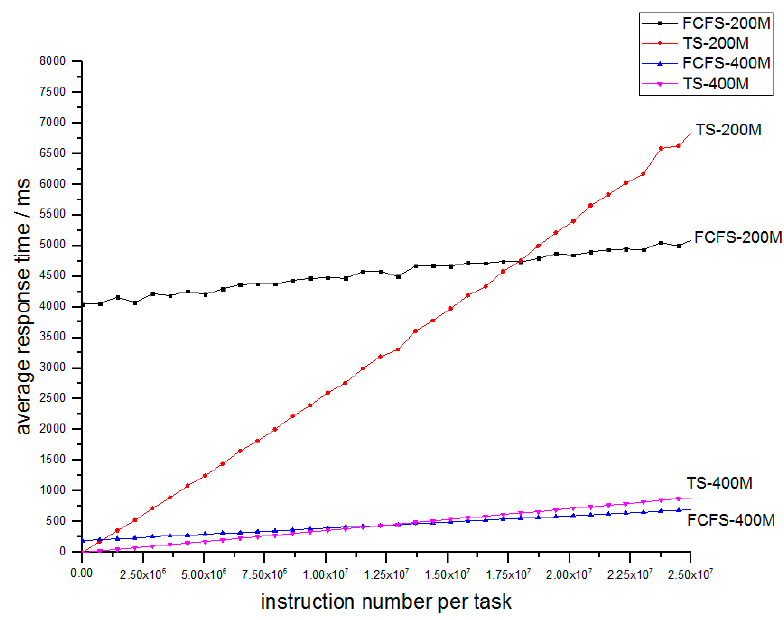
Figure 9. Relation of average response time and number of instructions for FCFS-200M and TS-200M, FCFS-400M and TS-400M.